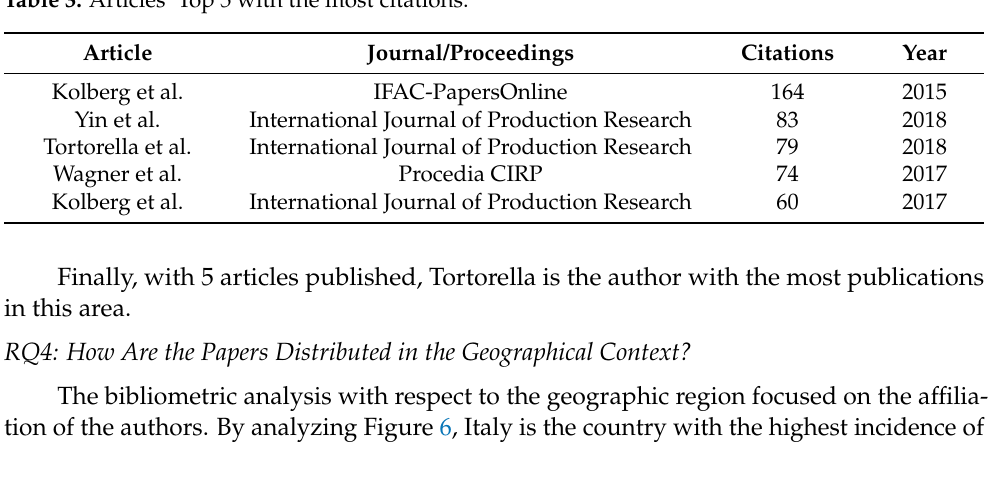
Figure 5. Journals’ Ranking distribution. Table 3. Articles’ Top 5 with the most